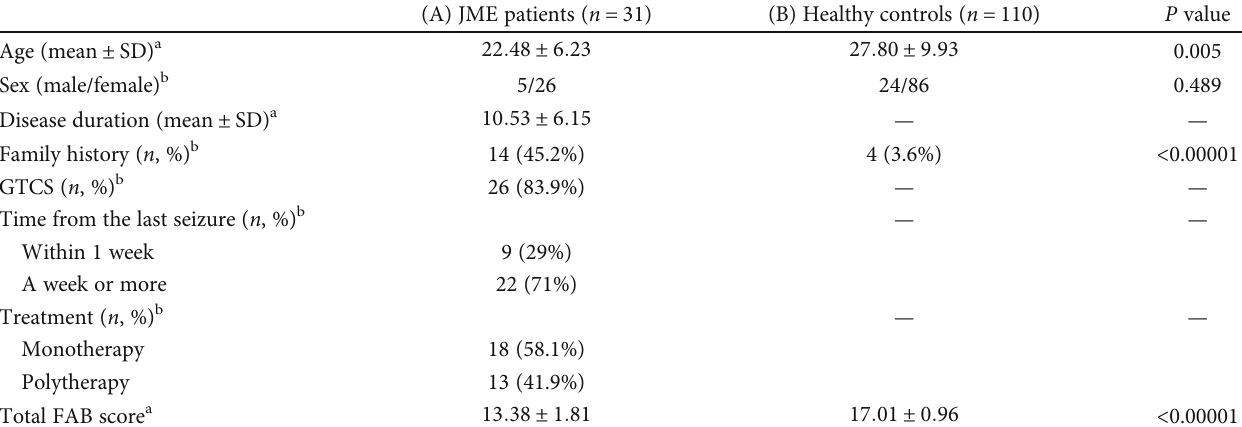
Table 1: Demographic and clinical characteristics of patients and healthy